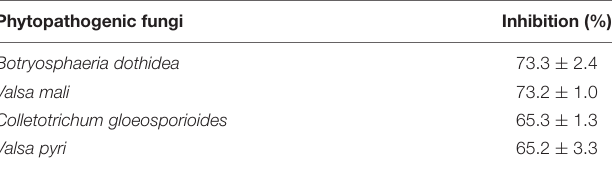
TABLE 1 | The inhibition of strain P2-1 against phytopathogenic